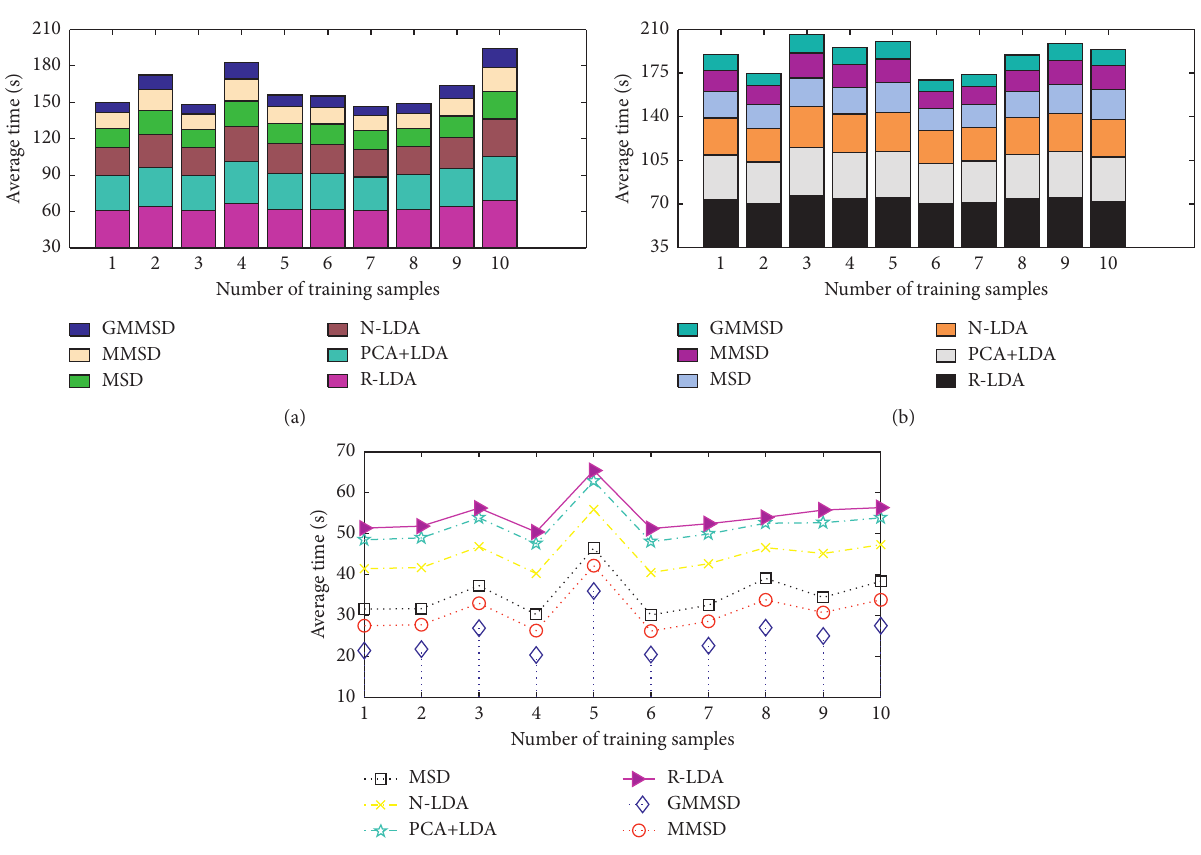
Figure 8: Comparison of computational complexity. (a) RML library. (b) FERET library. (c) Yale library.